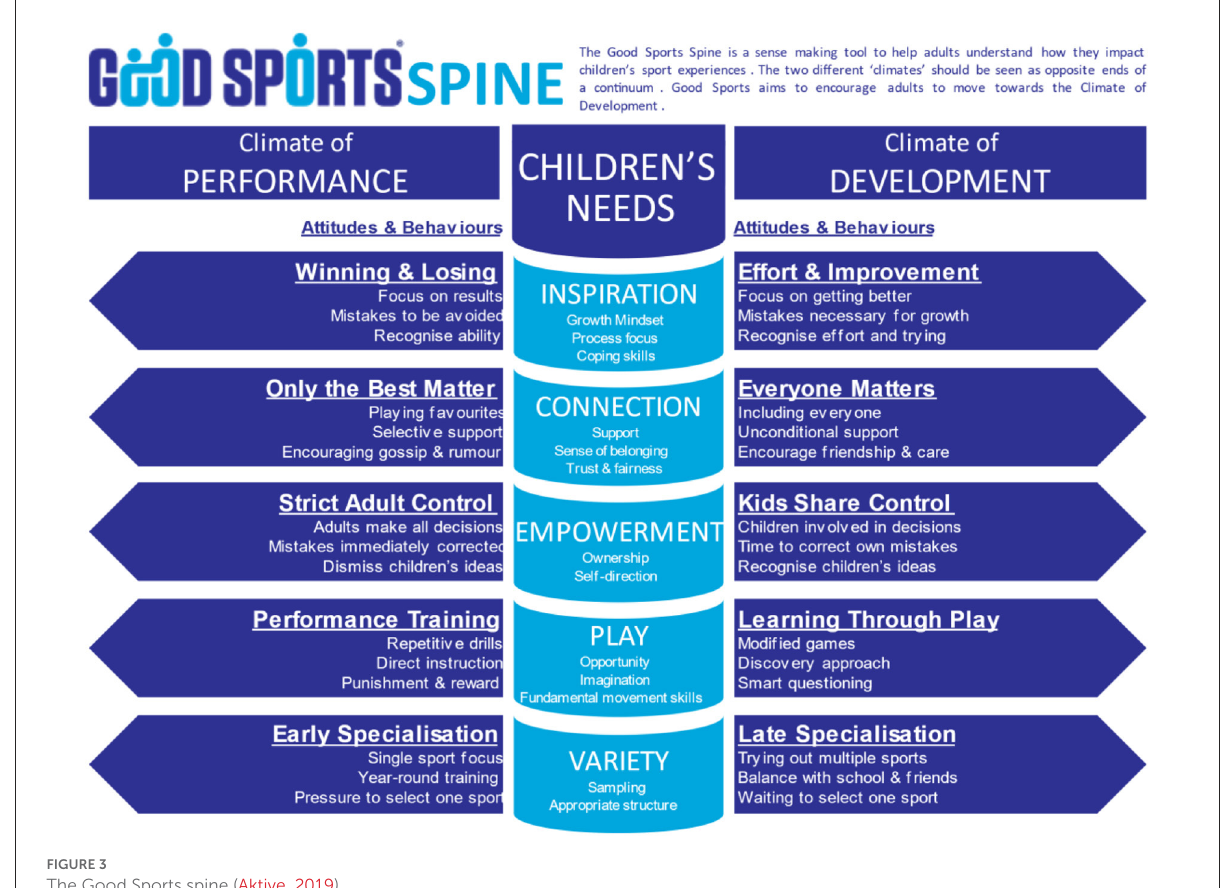
FIGURE3 The Good Sports spine (Aktive,